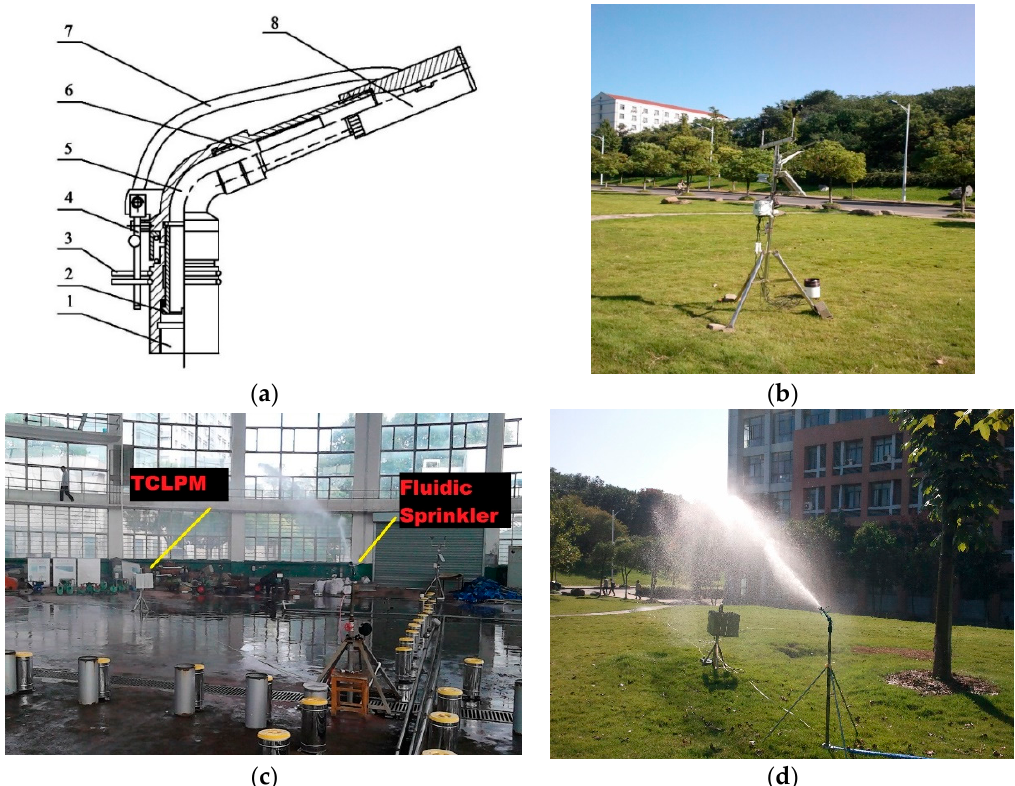
Figure 1. Schematic and pictorial views of fluidic sprinkler and experimental set-up. ( a ) Schematic view of the fluidic sprinkler. 1-Swivel connection; 2-Connecting sleeve; 3-Limiting mechanism; 4-Reversing mechanism; 5-Body sprayer; 6-Pipe sprayer; 7-Plastic tube; 8-fluidic component; ( b ) Campbell Scientific-WxPRO Research Grade Entry Level -Weather Station; ( c ) Measurement in no wind [24]; ( d ) Measurement in Table 1. Design specifications of the fluidic sprinkler used.